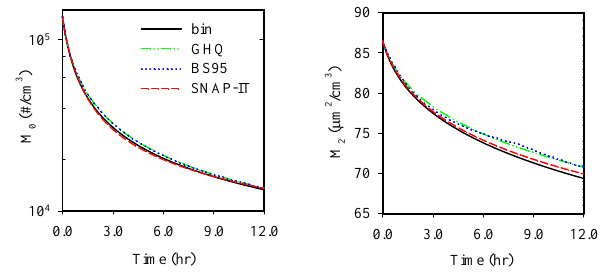
Figure 11: Evolution of M 0 (left panel; in logarithmic scale) and M 2 (right panel; in linear scale) due Fig. 11. Evolution of M 0 (left panel; in logarithmic scale) and M 2 to Brownian coagulation according to the SNAP-IT (red dashed curve), BS95 (blue dotted curve), (right panel; in linear scale) due to Brownian coagulation accord- ing to the SNAP-IT (red dashed curve), BS95 (blue dotted curve), GHQ (green dash-dotted curve) and binned (thick black curve) calculations. GHQ (green dash-dotted curve) and binned (thick black curve) cal-